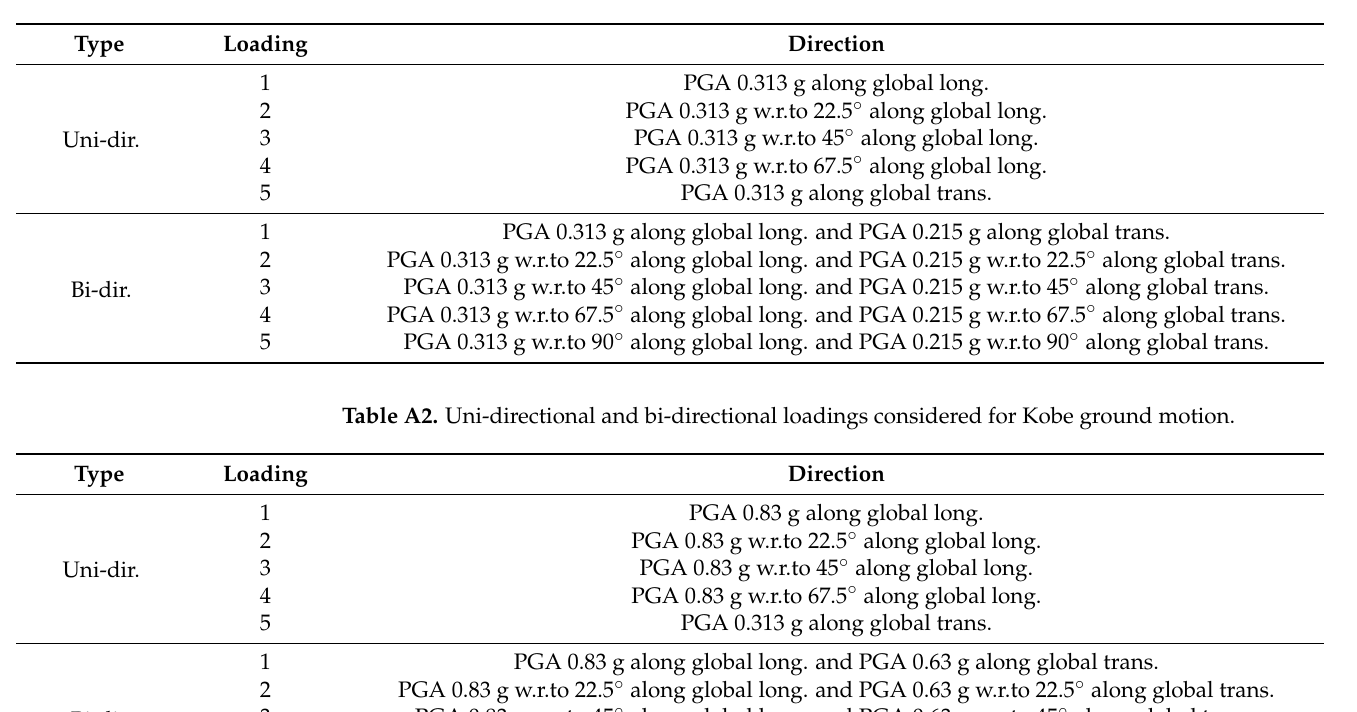
Table A1. Uni-directional and bi-directional loadings considered for Imperial Valley ground motion.